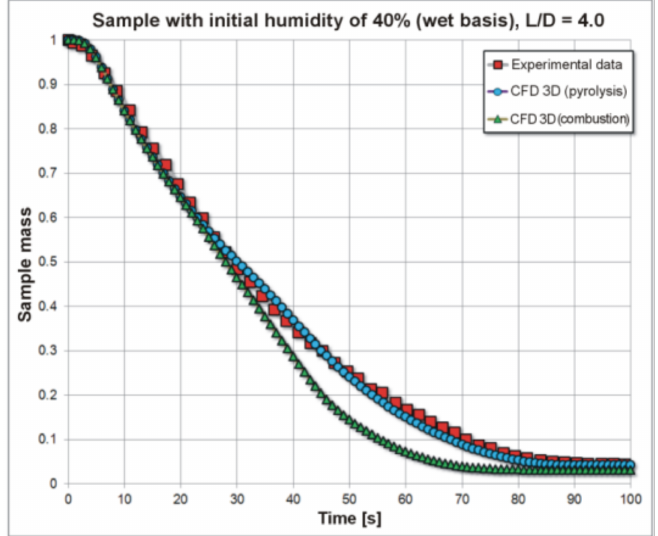
Figure 14. Comparison between simulated and experimental results [2] for the combustion of the sample with 40% initial moisture (compared with wet mass) and L/D = 4—3D